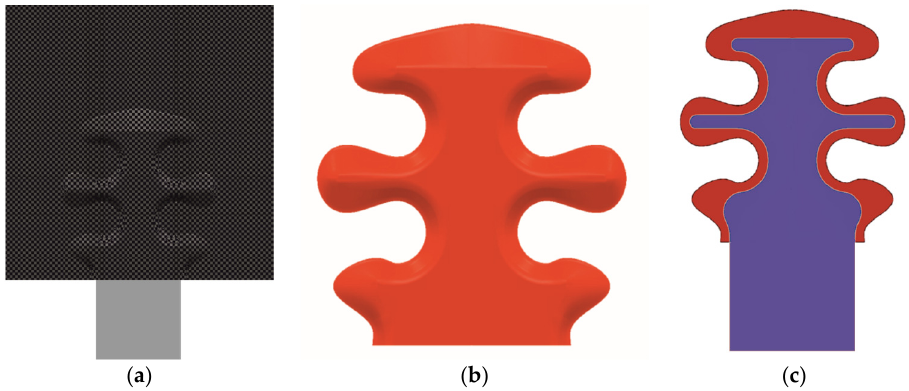
Figure 1. Illustrations of ( a ) the hybrid ( b ) the PPA-GF30 overmoulded insert and ( c ) the aluminium insert.